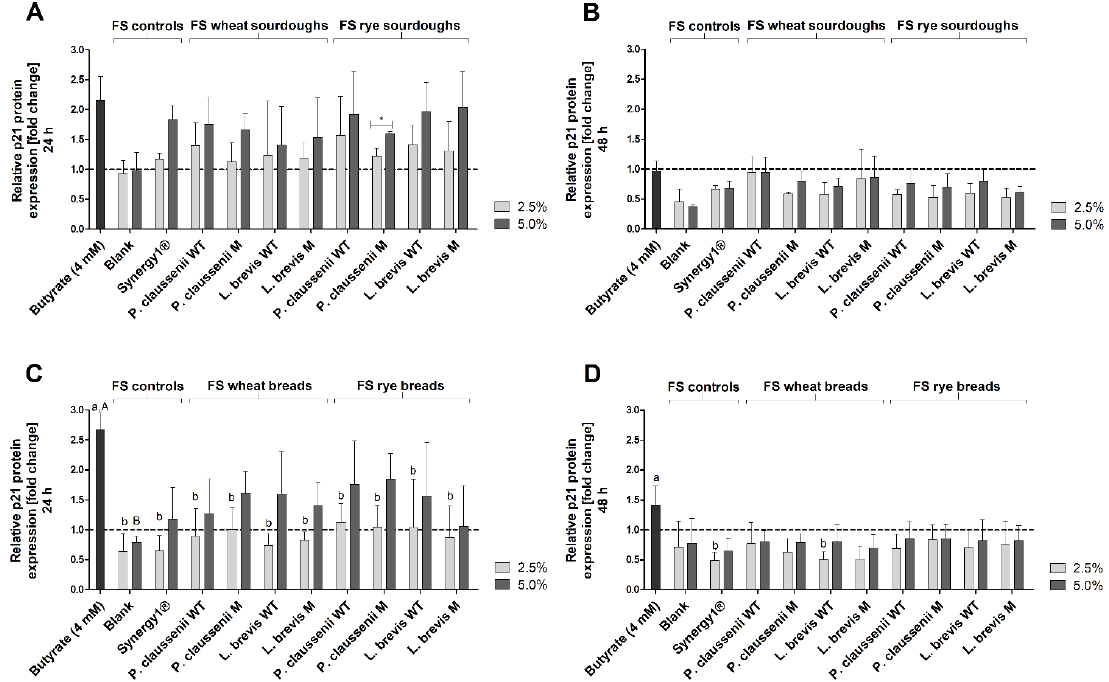
Figure 9. Relative p21 protein expression in LT97 cells after treatment with 2.5% and 5% fermentation supernatants (FS) obtained from controls (blank, Synergy1 ® ) and wheat and rye sourdoughs, as well as 4 mM butyrate for 24 h ( A ) and 48 h ( B ) and with FS obtained from controls (blank, Synergy1 ® ) and wheat and rye breads as well as 4 mM butyrate for 24 h ( C ) and 48 h ( D ) (mean + SD, n = 3). Results are presented as fold changes based on a medium control, which was set 1 (dashed line). Sourdoughs and breads were generated using wild-type (WT) and mutant (M) strains of Pediococcus claussenii (WT: TMW 2.340, M: TMW 2.2123) and Levilactobacillus brevis (WT: TMW 1.2112, M: TMW 1.2320). Significant differences between cells treated with 2.5% FS as well as butyrate ( a,b p < 0.05) and 5% FS as well as butyrate ( A,B p < 0.05) were obtained by one-way ANOVA and F-test according to Ryan–Einot–Gabriel–Welsh. Different letters represent significantly different results. Significant differences between cells treated with 2.5% and 5% FS were obtained by unpaired Student’s t -test (* p < 0.05). TMW: Technische Mikrobiologie Weihenstephan. The relative protein expression of cyclin D2 was markedly reduced in LT97 cells after 24 h treatment with butyrate (sourdough fermentation series: 0.2 ± 0.1-fold, bread fermen- tation series: 0.2 ± 0.0-fold) and 5% FS obtained from Synergy1 ® (sourdough fermentation series: 0.3 ± 0.0-fold, bread fermentation series: 0.4 ± 0.1-fold) as well as FS obtained from wheat and rye sourdoughs (0.4 ± 0.1-fold, on average) and breads (0.4 ± 0.3-fold, on average) (Figure 10A,C). In most cases, these cyclin D2 protein levels were significantly lower than after treatment with 2.5% and 5% of the blank FS (sourdough fermentation series: 2.5% FS: 1.2 ± 0.1-fold, 5% FS: 1.3 ± 0.2-fold, bread fermentation series: 2.5% FS: 1.0 ± 0.2-fold, 5% FS: 1.1 ± 0.2-fold) or with 2.5% FS of the sourdough (1.0 ± 0.3-fold,